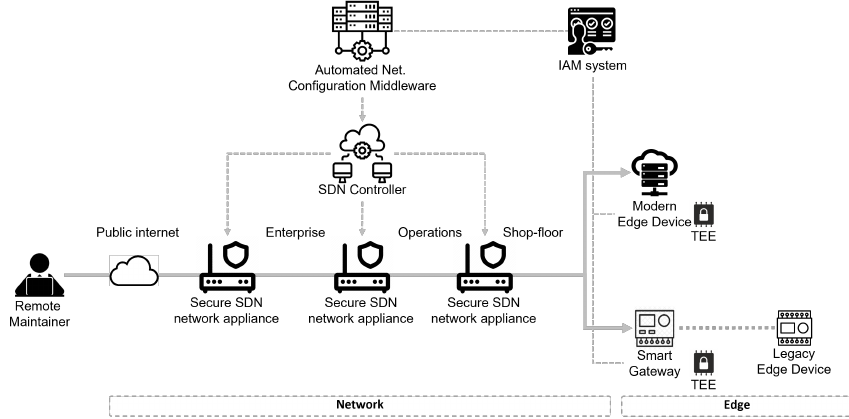
Figure 7. Prototype architecture.